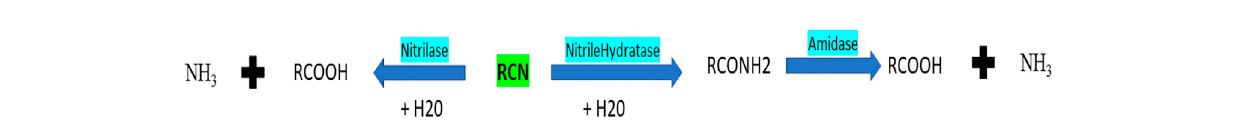
FIGURE 1 Mechanism of nitrilase, nitrile hydratase, and